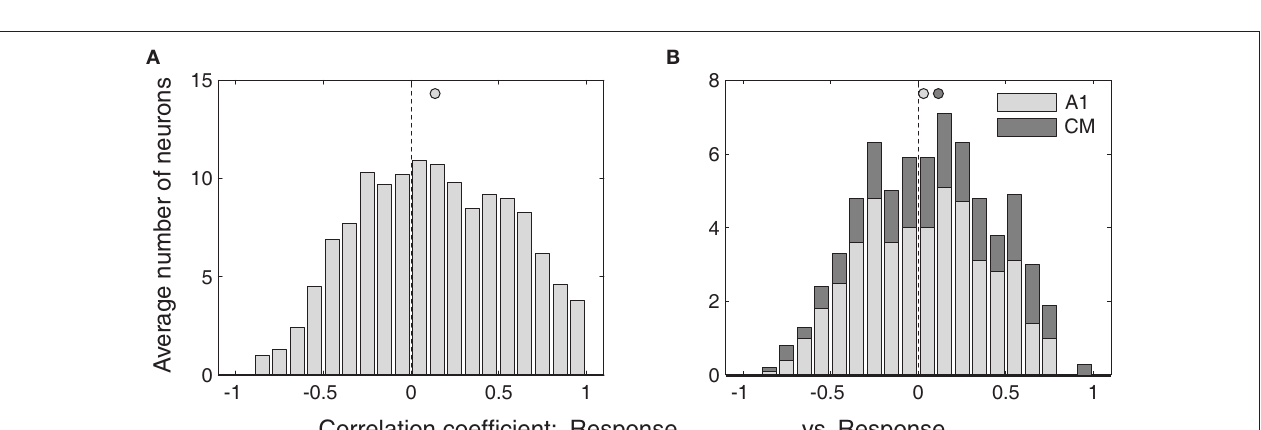
FIgure 7 | effects of eye position, for each sound location, in IC neurons. The correlation of baseline versus stimulus period (A) and stimulus minus baseline versus stimulus periods (B) for each IC neuron, broken down by sound location. Each neuron-sound location combination was treated as a separate case. Filled circles indicate the